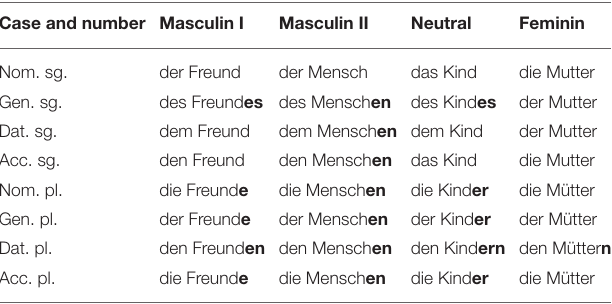
TABLE 2 | German noun